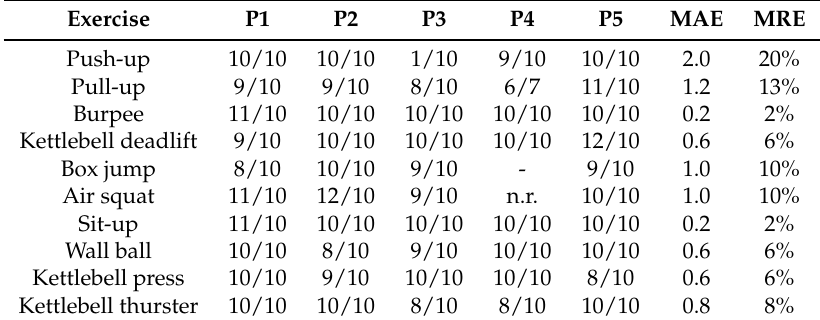
Table 8. Predicted repetition number versus actual number of repetitions of the unconstrained workout for five participants. n.r.: Not recognized, -: Not performed.